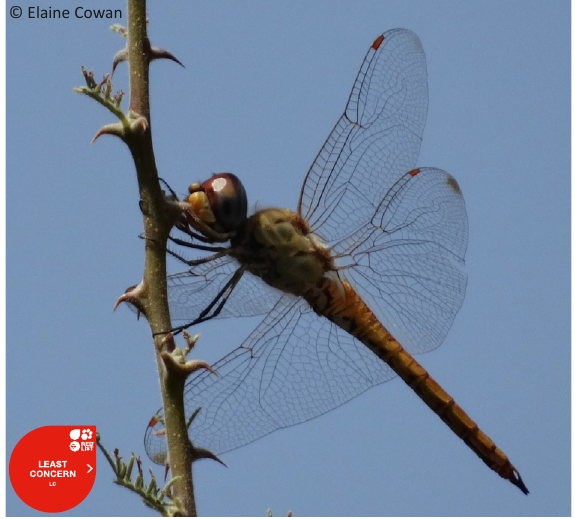
Image 31. Male Pantala flavescens, 1 September 2013 (photographed at silt flat above the pool, 23 0 05.37′N & 57 0 25.90’E, elevation 1310m). Note hindwing is very broad (to abdominal segment 5) with wavy veins in outer wing and brown wingtips.